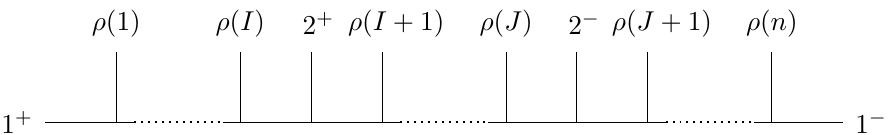
Figure 10 . The two-loop BCJ master diagrams are half-ladder diagrams with (cid:12)xed endpoints, which we choose to be the legs 1 + and 1 (cid:0) associated to the loop momentum 1. Half of the master diagrams have the relative ordering of legs 2 + and 2 (cid:0) represented in this (cid:12)gure, and they arise from the (cid:12)rst part of (3.1), associated to the scattering equations E (2 ; +) a = 0. The second half of the master diagrams have the other relative ordering of legs 2 + and 2 (cid:0) , and are associated to the scattering equations E (2 ; (cid:0) ) a =